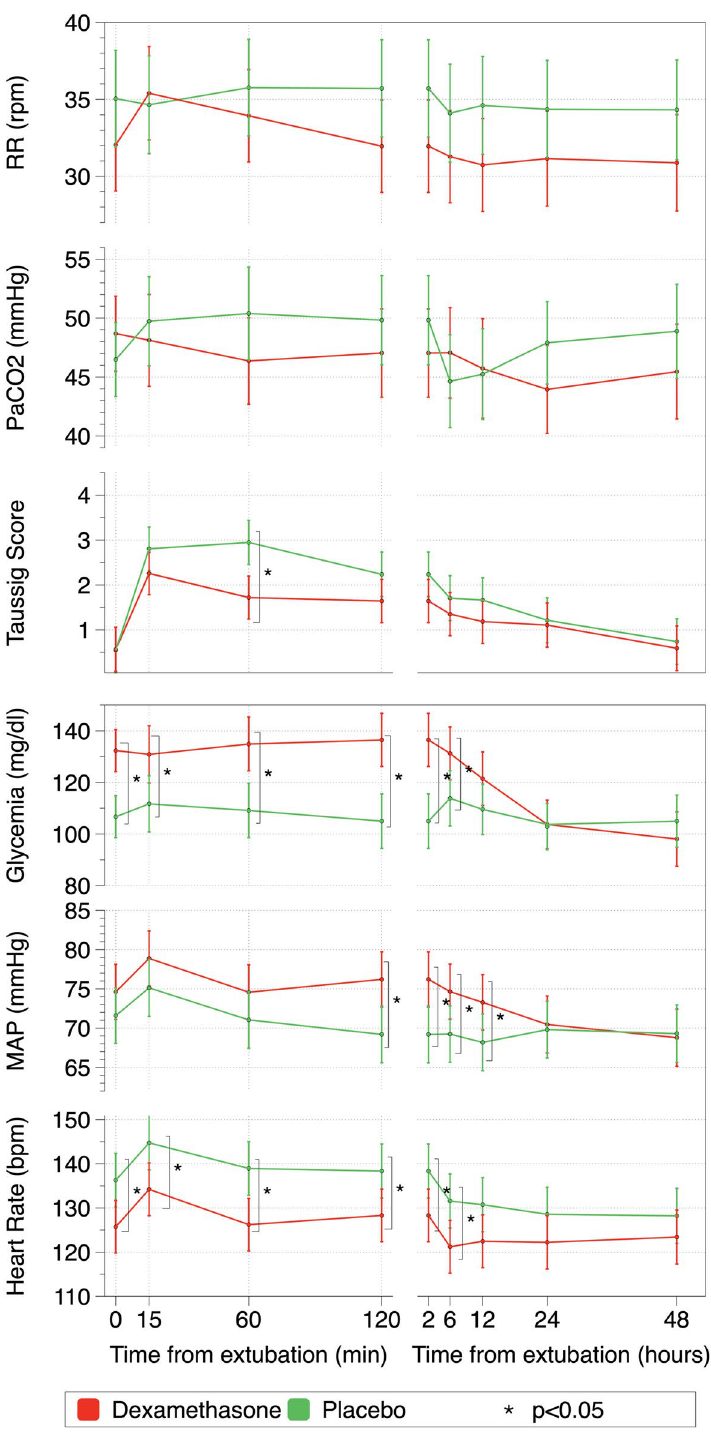
Figure 2. Linear mixed model comparing evolution over time of estimated means and 95% CI after extubation of respiratory (Taussig score, arterial CO2 paCO2 and respiratory rate (RR)), hemodynamic and metabolic parameters (heart rate, mean arterial pressure (MAP) and glycemia). Significant differences in different moments of follow-up ( p < 0.05) were marked as